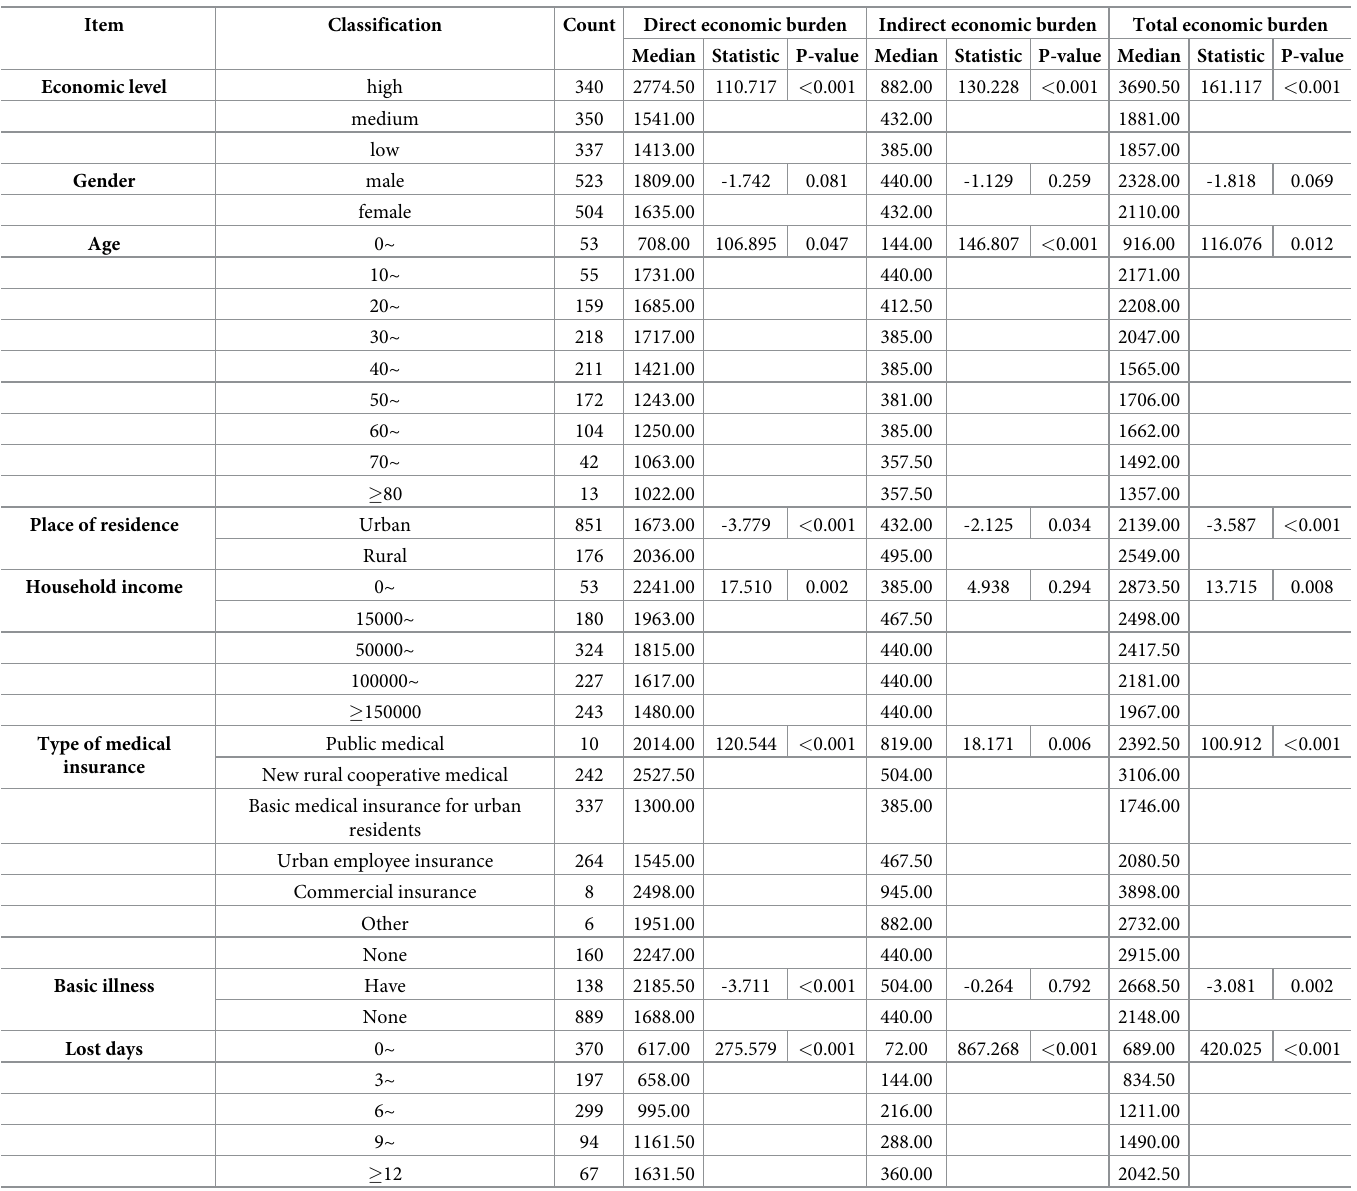
Table 1. Economic burden of patients with different types of dengue fever